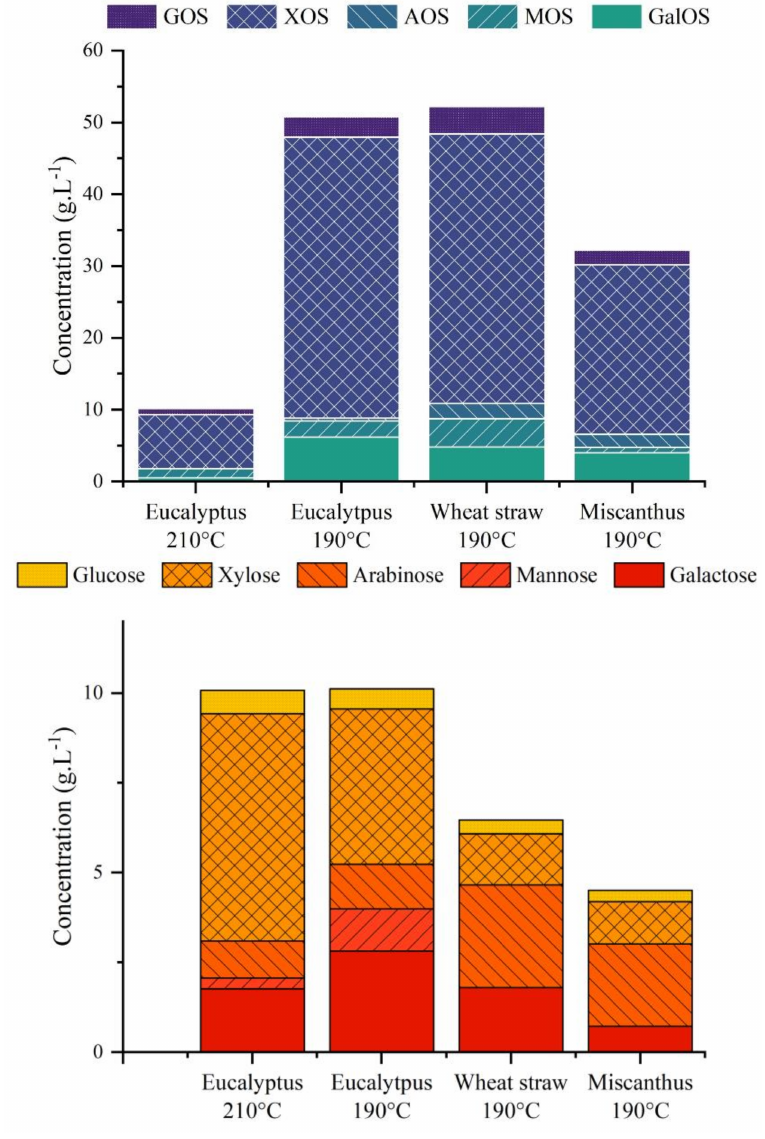
Figure 2. Oligosaccharide ( top ) and free sugar ( bottom ) compositions in concentrated autohydrolysis